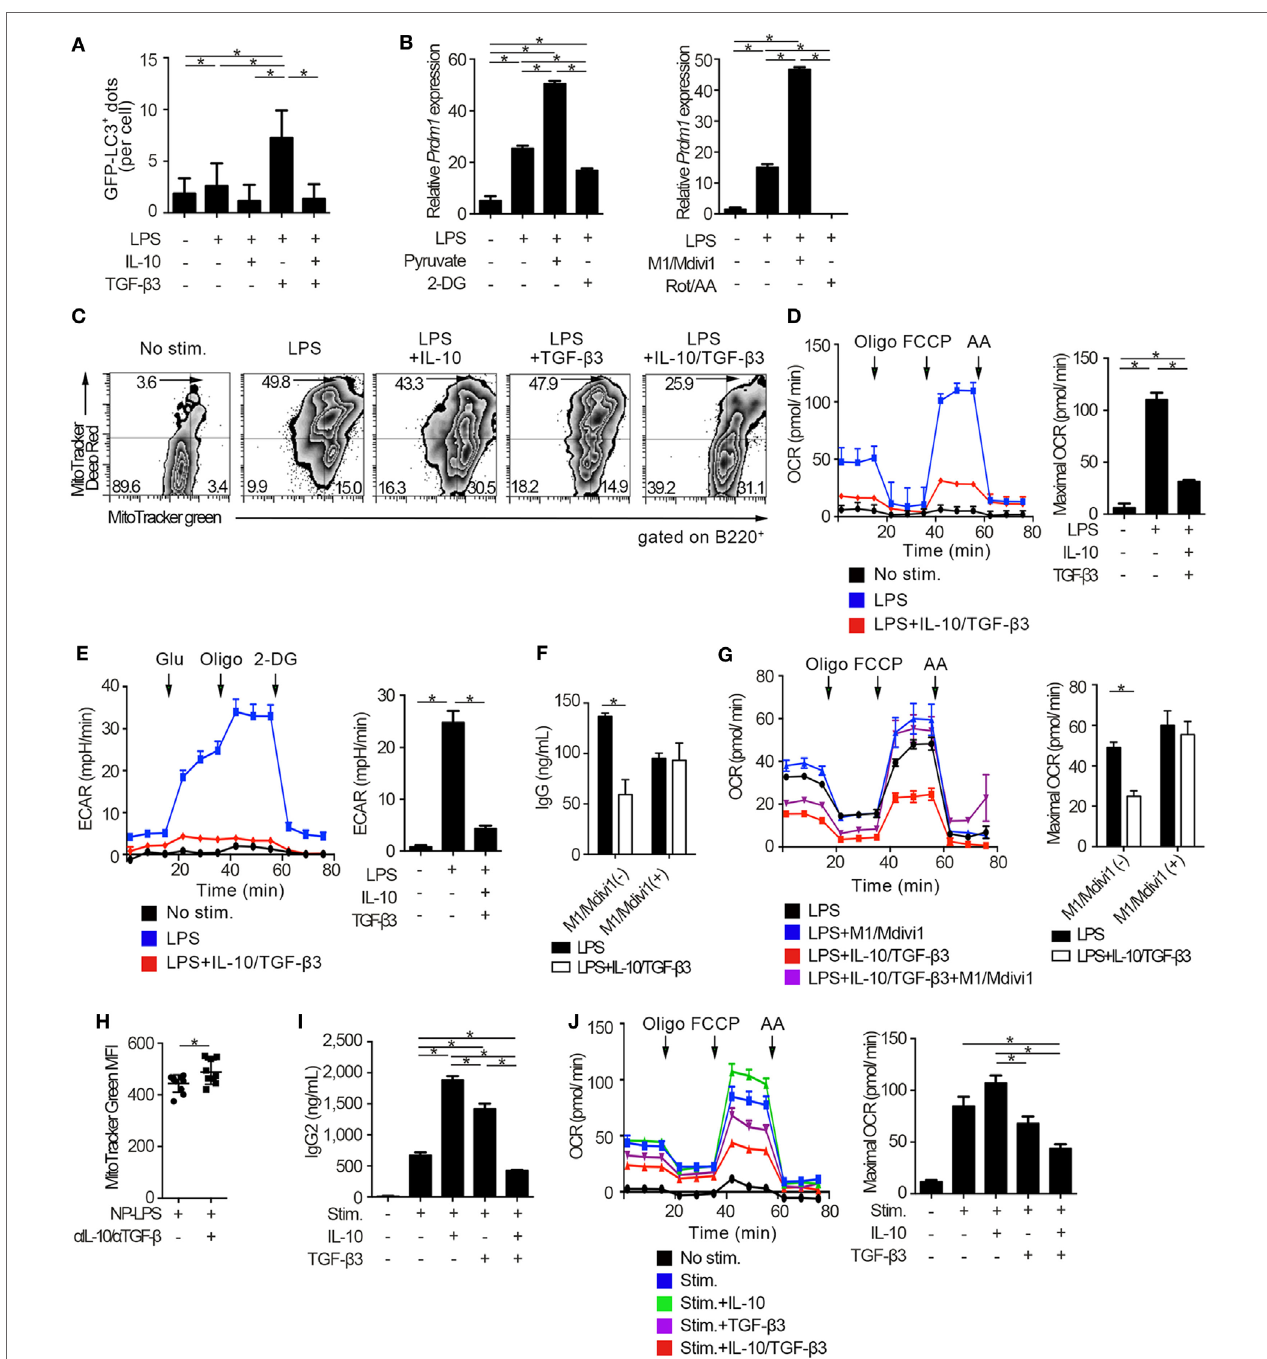
FigUre 6 | Cytokine synergy of TGF- β 3 and interleukin-10 (IL-10) regulates metabolism in toll-like receptor-stimulated B cells. (a) Splenic B cells from LC3-green fluorescent protein (GFP) mice were stimulated by lipopolysaccharides (LPS) either with TGF- β 3 and/or IL-10 for 3 days. GFP − LC3 + spots captured by fluorescence microscopy were counted manually ( n = 20). (B) Relative Prdm1 expression in LPS-stimulated B cells either with 1 mM 2-DG, 10 mM sodium pyruvate, 0.5 µM rotenone (Rot)/antimycin A (AA), or 10 µM M1/Mdivi1 analyzed by qRT-PCR ( n = 3). (c) Flow cytometric analysis of MitoTracker-stained, LPS-stimulated B cells with each cytokine cultured for 3 days. (D,e) Oxygen consumption rate (OCR) (D) and ECAR (e) of LPS-stimulated B cells with each cytokine measured by extracellular flux analyzer ( n = 3). (F,g) IgG antibody titers quantified by ELISA (F) and OCR measured by extracellular analyzer (g) of LPS-stimulated B cells with or without TGF- β 3 and IL-10 in the presence or absence of 10 µM M1/Mdivi1 ( n = 3). (h) Mean fluorescence intensity (MFI) of MitoTracker Green in splenic B220 + cells from B6 mice treated as in Figure 2e ( n = 9–10). (i) Human B cells were stimulated by 2.5 µg/ml CpG-ODN, 1,000 U/ml IL-2, 10 ng/ml IL-6, and 0.5 µg/ml anti-CD40 with 10 pg/ml TGF- β 3, 10 ng/ml IL-10, and/or 1 µg/ml anti-IL-10 Ab for 7 days ( n = 3). IgG2 antibody titers of the supernatants were quantified by ELISA. (J) OCR of CpG-ODN-stimulated human B cells with each cytokine for 3 days measured by extracellular flux analyzer ( n = 3). P < 0.05 by one-way (a,B,D,e,i,J) , two-way (F,g) analysis of variance followed by Bonferroni’s multiple comparisons test, or Student’s t -test (h) . Error bars, SD. (B,F,h,i) and SEM. (D,e,g,J)